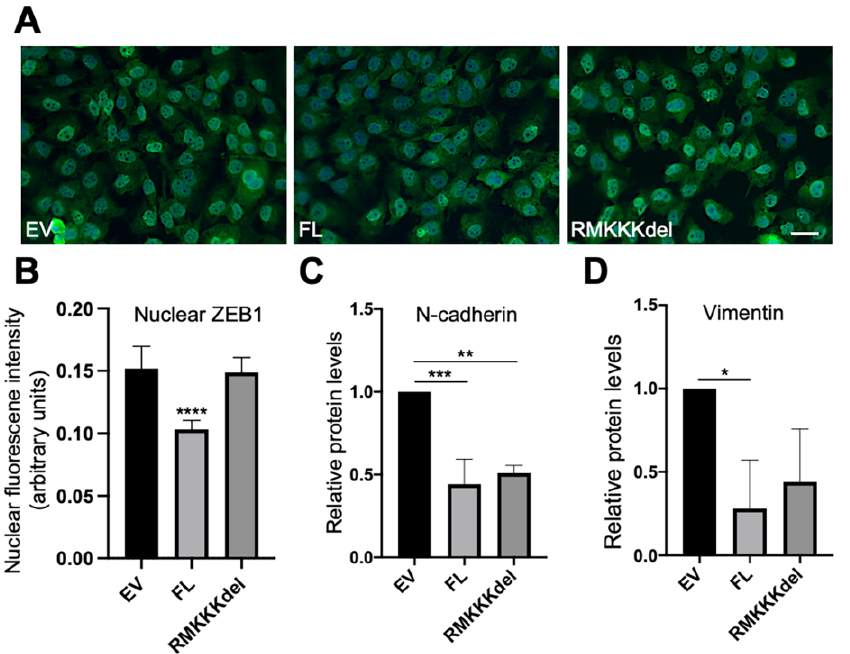
Figure 6. Effect of overexpression of SDC1 on EMT markers in B6FS fibrosarcoma cells. ( A ) Immunofluorescent staining of ZEB1 in B6FS cells expressing empty vector (EV), FL SDC1 (FL), or the RMKKKdel mutant. ( B ) Bar graph showing results from quantification of nuclear ZEB1 intensity in B6FS cells transfected with an EV, FL SDC1, or the RMKKKdel mutant. ( C , D ) Bar graphs showing protein levels of N-cadherin and vimentin in B6FS cells transfected with an EV, FL SDC1, or the RMKKKdel mutant. The results represent mean values normalized to GAPDH levels and are based on three experiments. Scale bar = 10 µm. * = p < 0.05; ** = p < 0.01; *** = p < 0.001; **** = p < 0.0001.